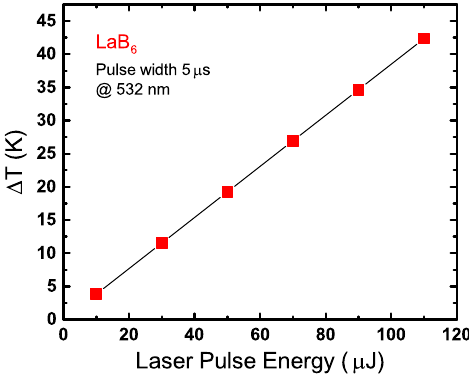
FIG. 7. Results of relative quantum efficiency measurement of LaB 6 cathode being irradiated at three different laser wave- lengths, 266, 355 and 532 nm, measured by heating up the cathode.